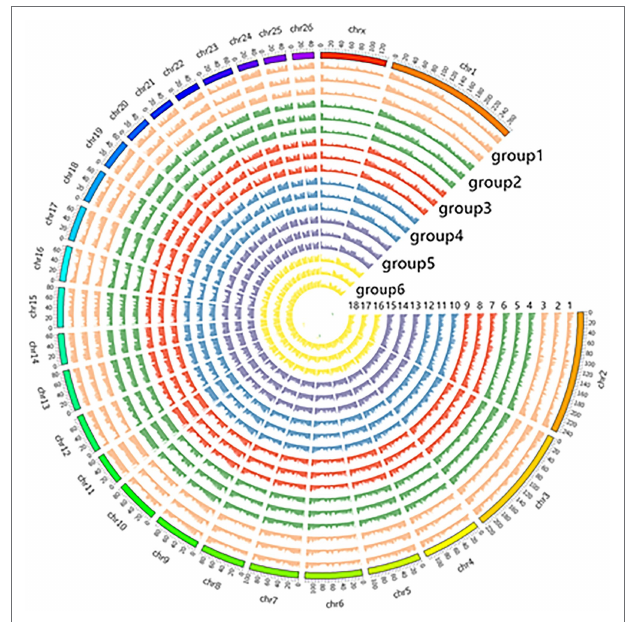
FIGURE 1 | Display of circos in genome-wide methylation levels.